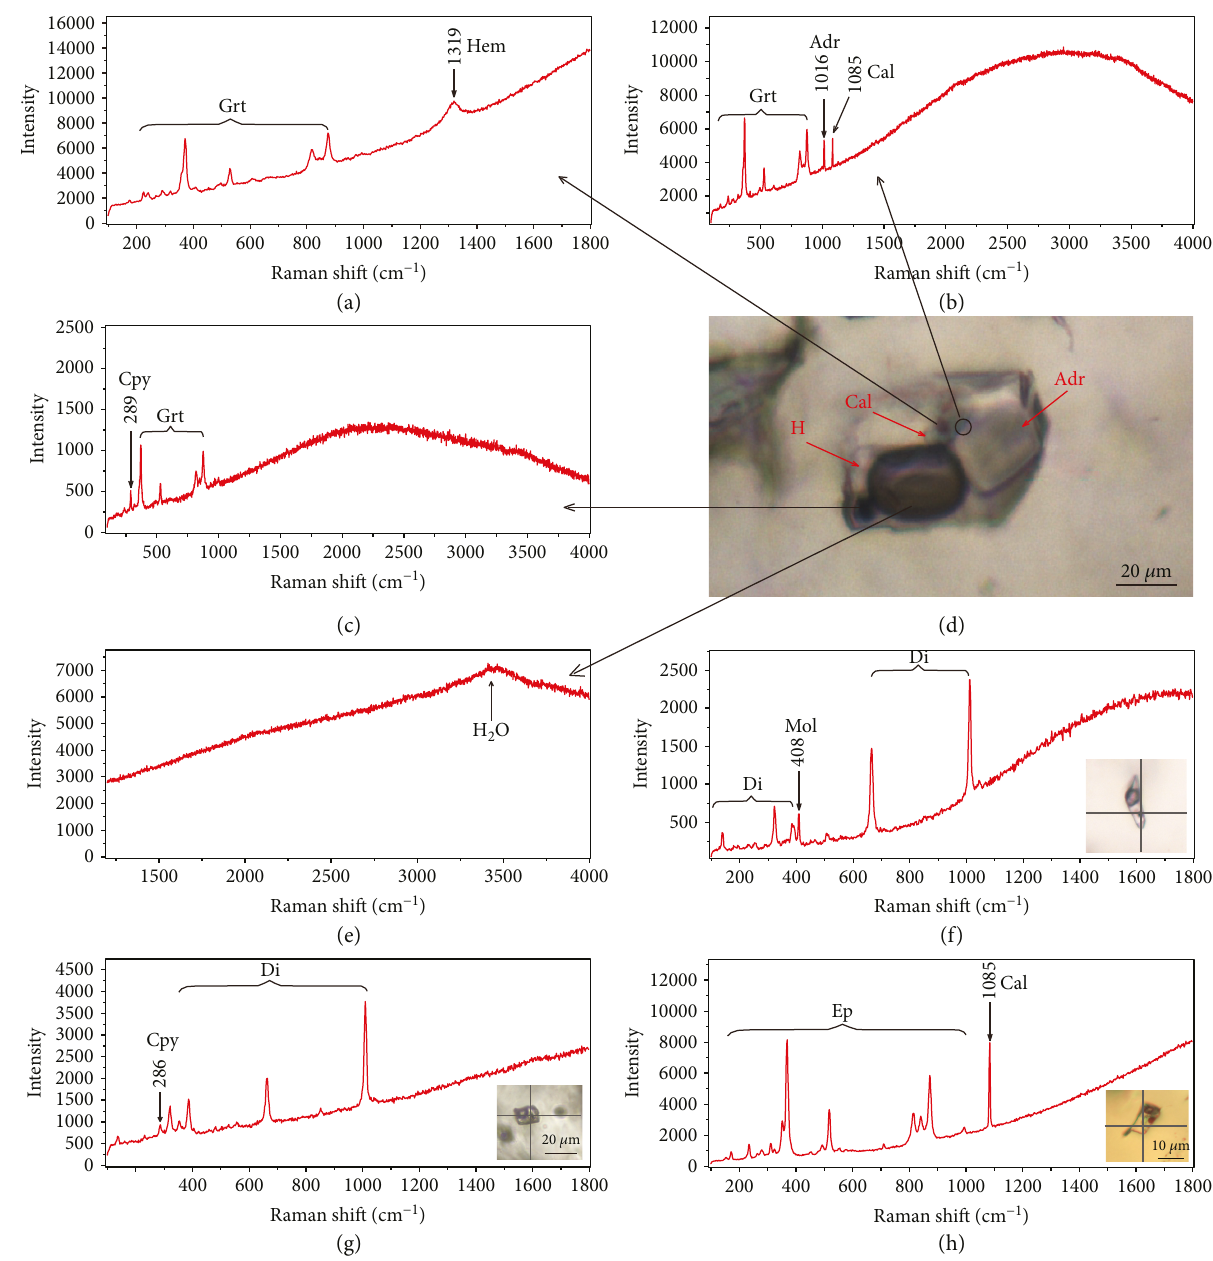
Figure 9: Representative Raman spectra of fl uid inclusions in the Fuzishan Cu-Mo deposit. (a) Hematite spectra of daughter mineral phase in (d) fl uid inclusion of prograde skarn stage garnet. (b) Both anhydrite and calcite spectra of daughter mineral phase in (d) fl uid inclusion of prograde skarn stage garnet. (c) Chalcopyrite spectra of daughter mineral phase in (d) fl uid inclusion of prograde skarn stage garnet. (e) H spectra of vapor phase in (d) fl uid inclusion of prograde skarn stage garnet. (f) Molybdenite spectra of daughter mineral phase in fl uid inclusion of prograde skarn stage diopside. (g) Chalcopyrite spectra of daughter mineral phase in fl uid inclusion of cubic diopside in prograde skarn stage early anhydrite. (h) Calcite spectra of daughter mineral phase in fl uid inclusion of retrograde skarn stage epidote. Cpy: chalcopyrite; Mol: molybdenite; Hem: hematite; Cal: calcite; Adr: anhydrite; H: halite; Grt: garnet; Di: diopside; Ep: